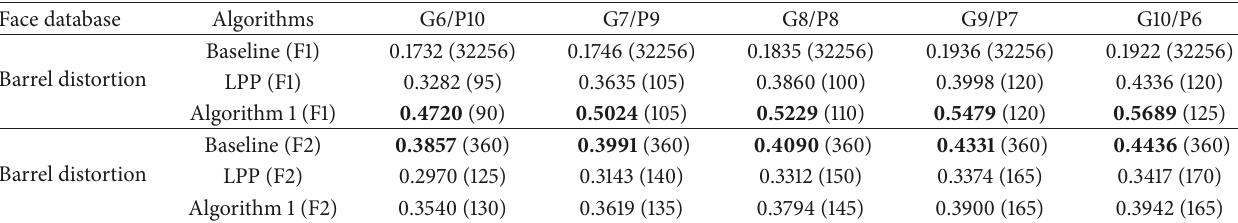
Table 18: The recognition rates on barrel distortion Extended Yale B face database over “F1” and “F2” features; recognition rates (dimensionality).